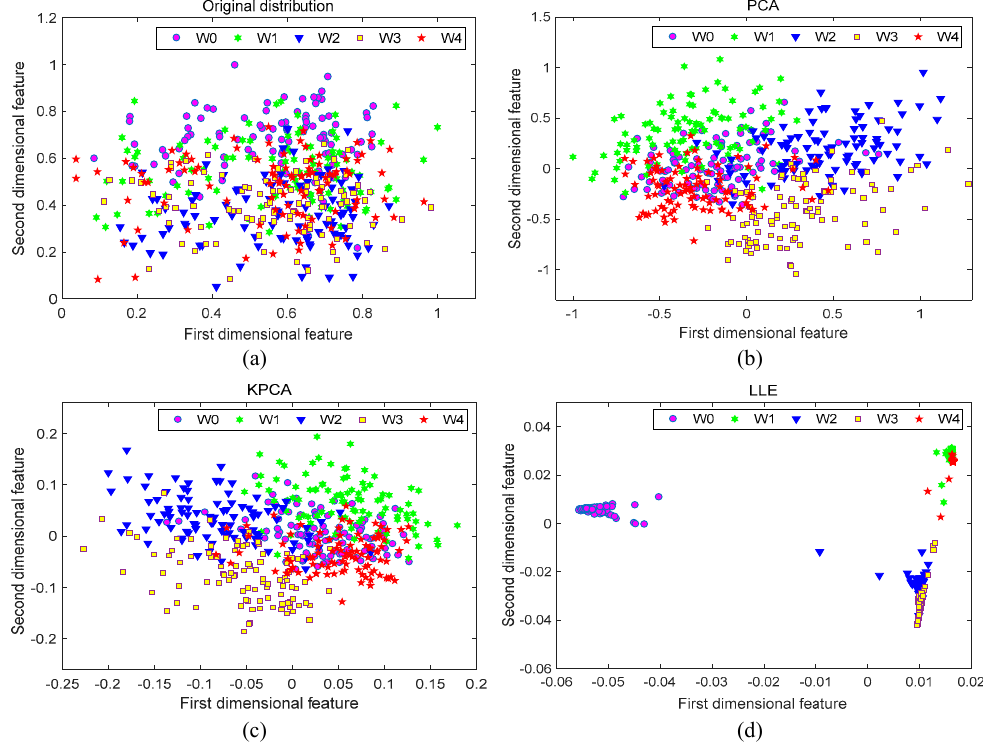
Figure 7. Visualization results of each dimensionality reduction method: ( a ) Original distribution; ( b ) PCA; ( c ) KPCA; ( d ) LLE.